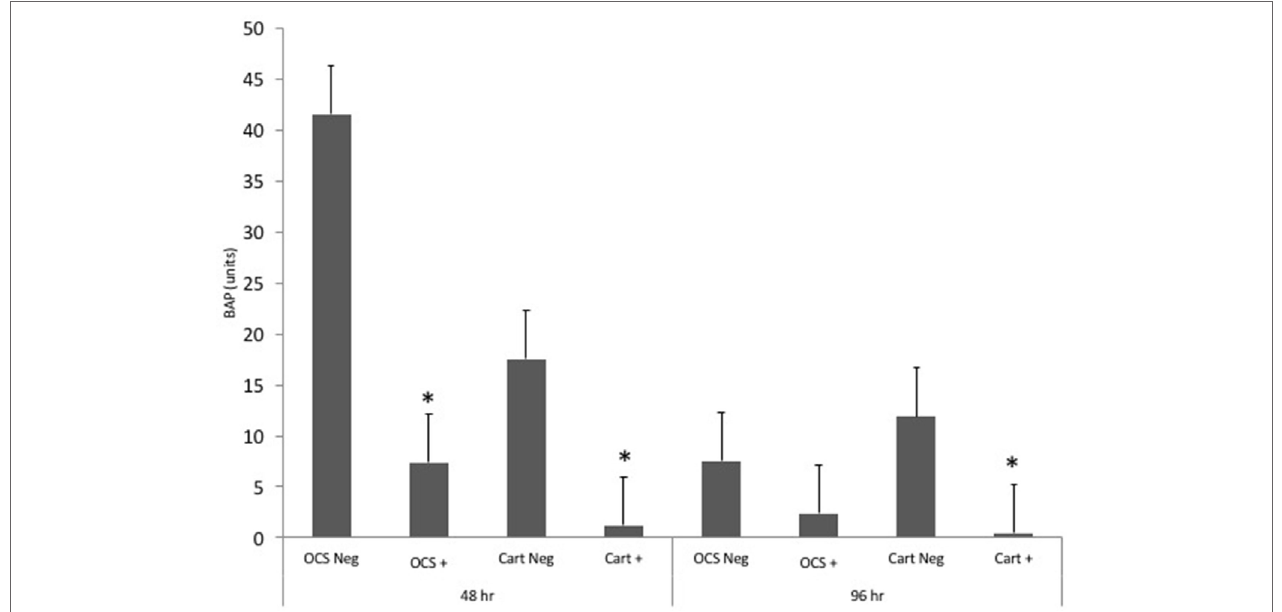
FigUre 5 | Mean ± SE concentrations of bone alkaline phosphatase (BAP) in media samples of cultures containing osteochondral and synovial explants (OCS) or cartilage explants alone (Cart) that were unstimulated (Neg) or stimulated with IL-1 (10 ng/mL; + ) at 48 and 96 h after initiation of treatments.